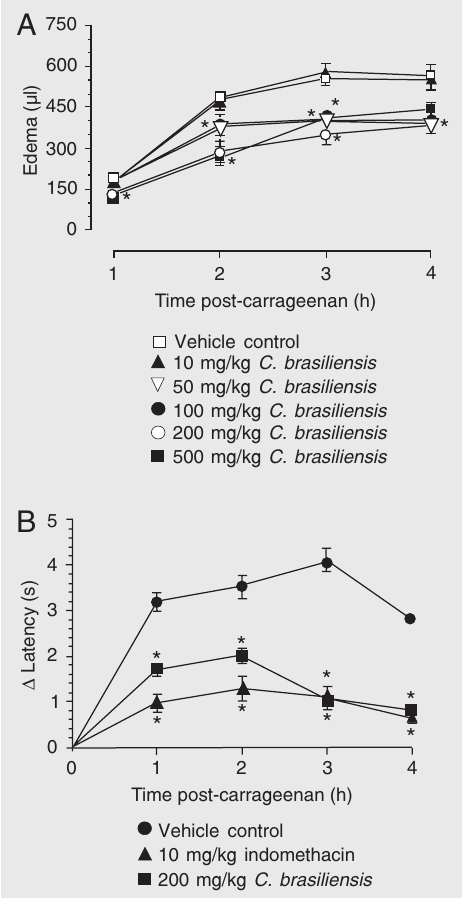
Figure 2. Effect of the acid frac- tion obtained from seeds of Car- potroche brasiliensis adminis- tered orally on the carrageen- an-induced rat paw edema (A) and hyperalgesia (B). Data are reported as means ± SEM for N = 9-11 animals per group. *P < 0.05 compared to the vehicle control group (Student t